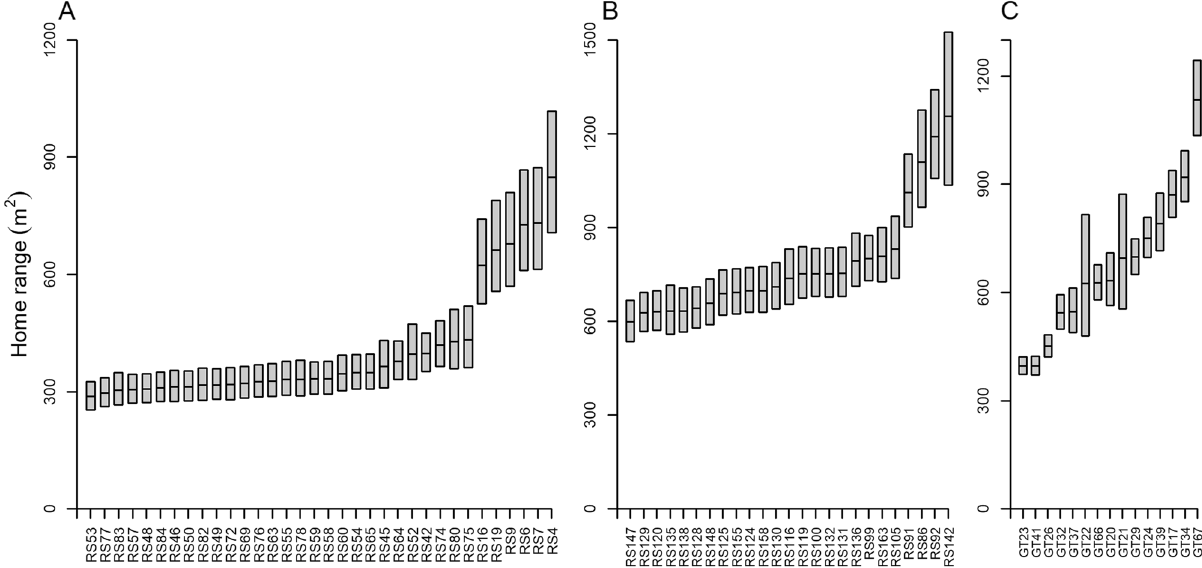
Figure 9. GAM predictions (with 95% CI) of hourly home range for individual ( A ) red snapper in the 30-m array, ( B ) red snapper in the 55-m array, and ( C ) gray triggerfish in the 30-m array. The best fit GAM model was modified to include Fish ID as a fixed, rather than random effect, and predictions were made based on the average conditions experienced by fish in each array, hence, ( A ) and ( B ) cannot be directly